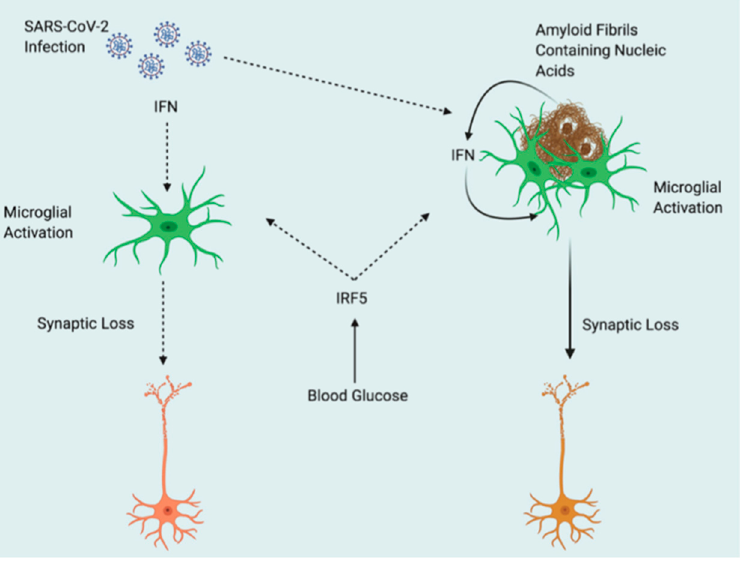
Figure 1. Potential Interactions Between “SARS-COV-2” and AD. Type 2 diabetes (T2D) acts as a predisposing factor for AD. Elevations in blood glucose resulting from T2D may exacerbate pathology in both AD and COVID-19, or comorbidity of the two, through increased activity of interferon regulatory factor 5 (IRF5). Type I interferons (IFN) mediate inflammation after viral infection and in response to nucleic acid containing amyloid fibrils, eventually leading to synaptic loss. Amyloid fibrils may entrap viral particles, leading to further enhancement of IFN response. Solid line arrows indicate proven mechanisms, dotted line arrows indicate theoretical mechanisms; from ref. [50] with authorization.